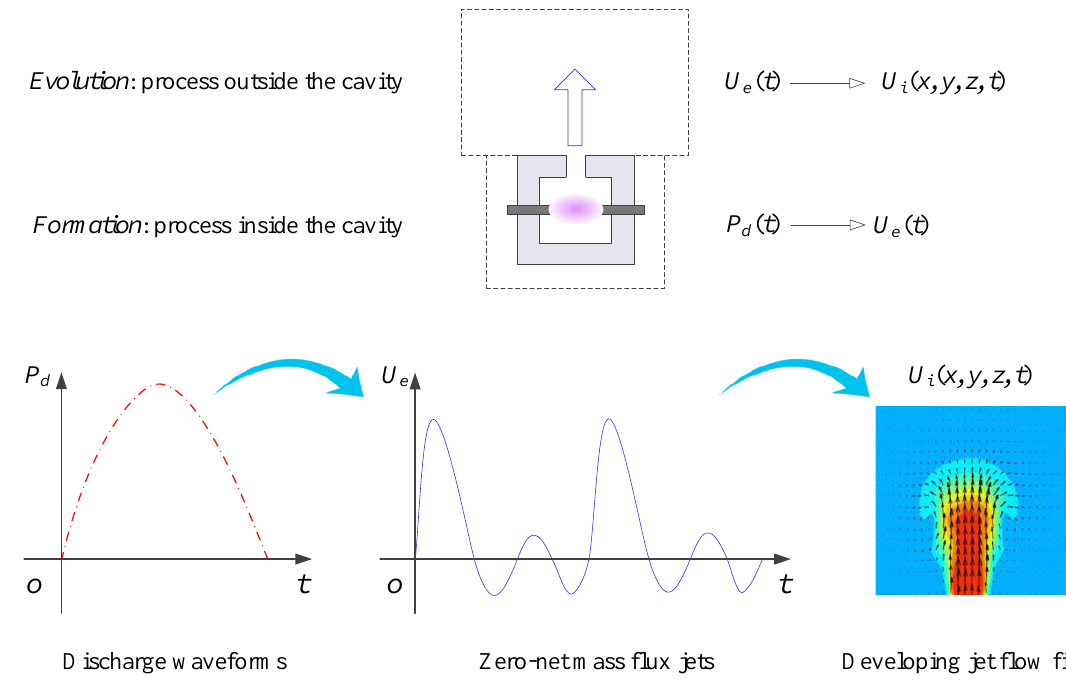
Figure 4. Sketch of formation (inside the cavity) and evolution (outside the cavity) process of plasma synthetic jets. P d and U e are the discharge power and the time-varying exit velocity, respectively. U i ( x , y , z , t ) ( i = x , y , z ) denotes the instantaneous velocity field of developing